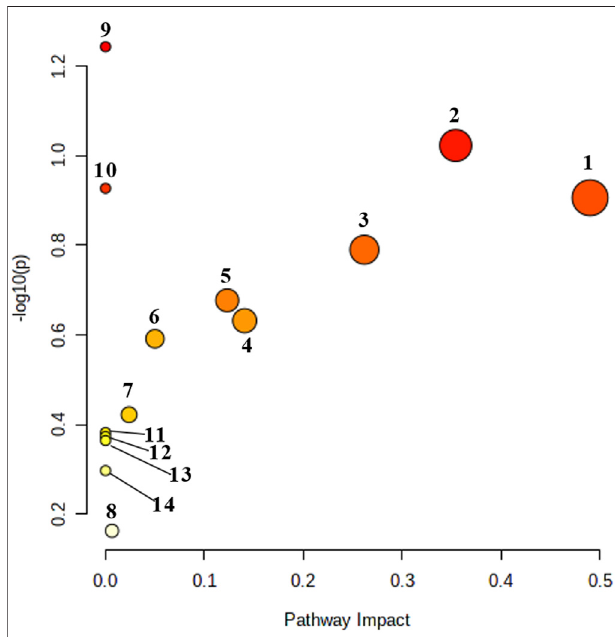
FIGURE 7 | Urine metabolic pathway analysis results. 1: Vitamin B6 metabolism; 2: Arachidonic acid metabolism; 3: Phenylalanine metabolism; 4: Pentose and glucuronate interconversions; 5: Histidine metabolism; 6: Citrate cycle; 7: Glyoxylate and dicarboxylate metabolism; 8: Steroid biosynthesis; 9: Phenylalanine, tyrosine and tryptophan biosynthesis; 10: Tryptophan metabolism. 11: Biosynthesis of unsaturated fatty acids;